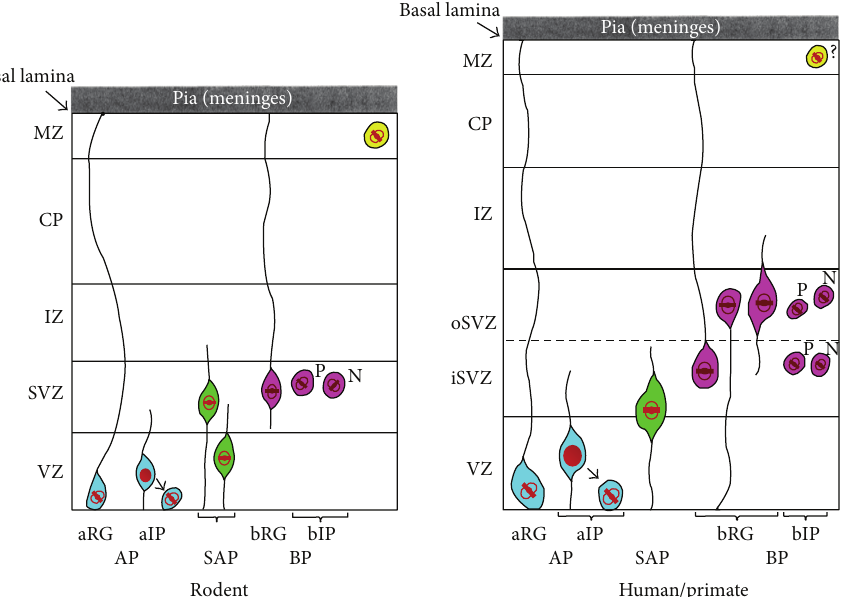
Figure 1: Summary of progenitor subtype diversity within the rodent and human/primate brain. Apical Progenitor (AP) cells (light blue) include apical Radial Glia (aRG) which attach to the basal lamina and apical Intermediate Progenitor (aIP) cells which have short processes. Both types of APs are defined by their mitotic division at the apical surface. Subapical Progenitor (SAP) cells (coloured green) are defined by their ventricular contact and abventricular mode of cell division. Basal Progenitor (BP) cells (magenta) are defined by their basal mitoses and comprise basal Radial Glia (bRG) cells attached to the basal lamina as well as basal Intermediate Progenitor (bIP) cells which undergo a proliferative division (labelled “P”) or neurogenic divisions (labelled “N”), as indicated. A yellow coloured marginal zone progenitor is represented in rodent cortex. In the human/primate cortex, AP and SAP cell types have been identified, while three types of bRGs have been identified including those with a basal attachment, an apical attachment, or only emanating short processes. The bIPs cell types which undergo proliferative or neurogenic divisions have been described in the iSVZ and oSVZ. The presence of MZ progenitor cells within the human/primate cortex remains to be clarified. VZ: ventricular zone, SVZ: subventricular zone, IZ: Intermediate Zone, CP: cortical plate, MZ: marginal zone, iSVZ: inner subventricular zone, and oSVZ: outer subventricular zone as presented. Relative sizes of rodent and human/primate compartments are not drawn to scale. See text for further